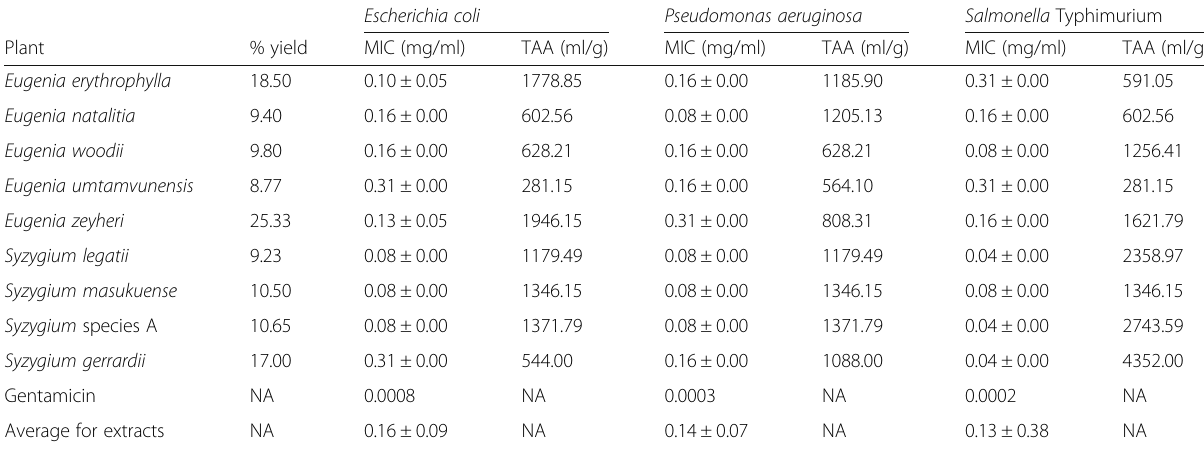
Table 2 Yield of extract, Minimum Inhibitory Concentration (MIC) and total antibacterial activity (TAA) of the nine selected acetone leaf extracts against Gram-negative test bacteria. Values equal to or less than 0.1 mg/ml indicate high activity